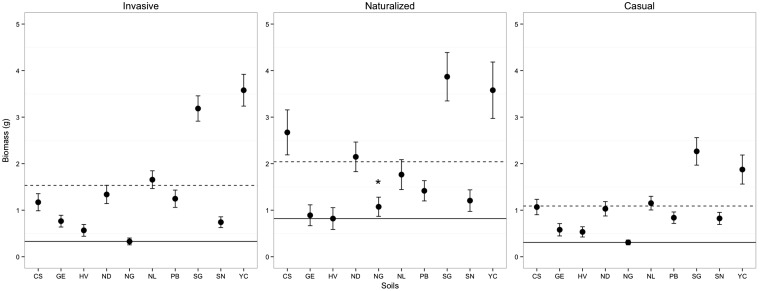
Average aboveground biomass (g) response of all Acacia species/replicates in each invasiveness categories to different soil inoculants in the native experiment (Australia). The horizontal solid line indicates the point at which host species within a given invasiveness category have the same biomass response as their least effective soil. The dashed line is the average biomass response for all host species within a given invasiveness category combined across all soils. The “*” indicates the soil in which there was a significant difference (P < 0.05) in biomass response of the invasiveness categories. Error bars represent standard errors (SE) of the means.